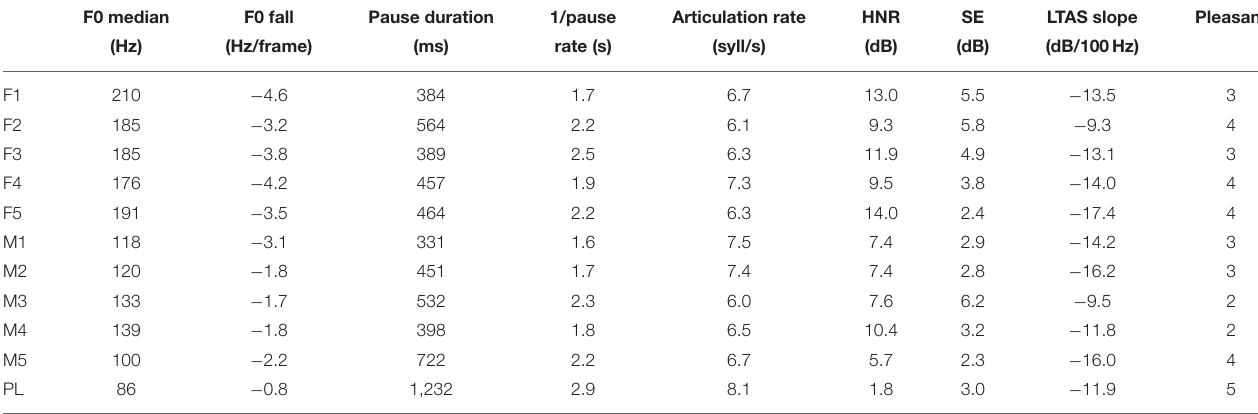
TABLE 2 | Mean values for significant predictors for Portuguese reciters (gender indicated by the first letter: F, female; M, male). F0 median F0 fall